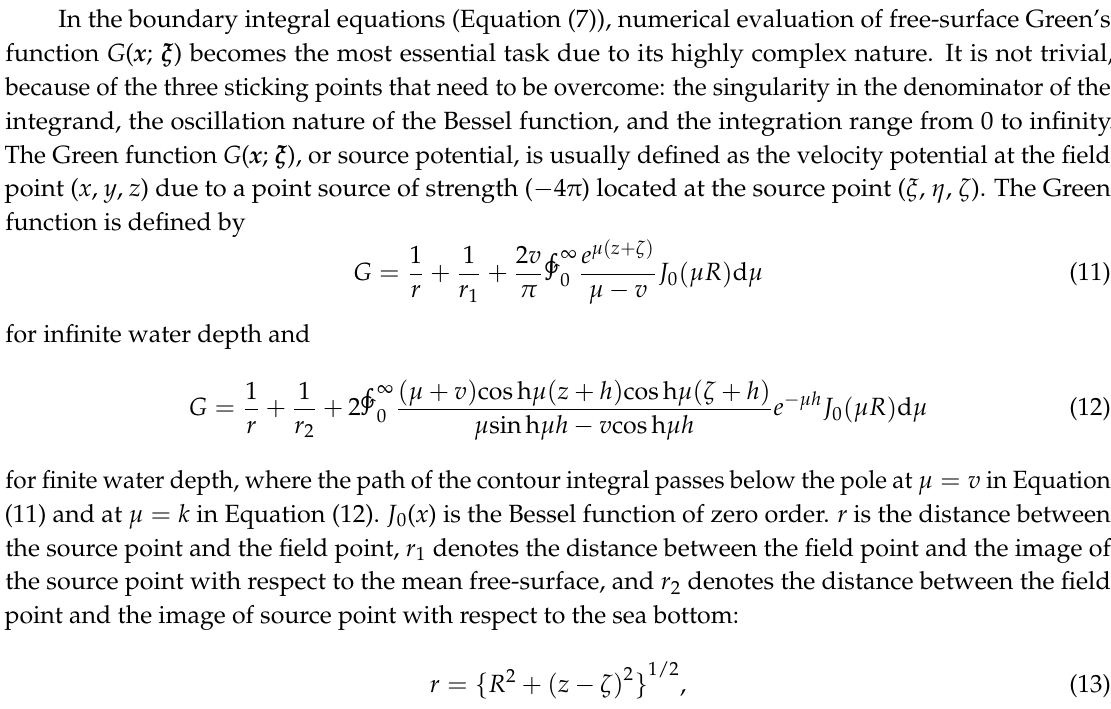
Figure 2. Illustration of the collection method: Collection points are located at the centroid of each panel, and the influence coefficients S ij and D ij between each two of these points are evaluated subsequently.